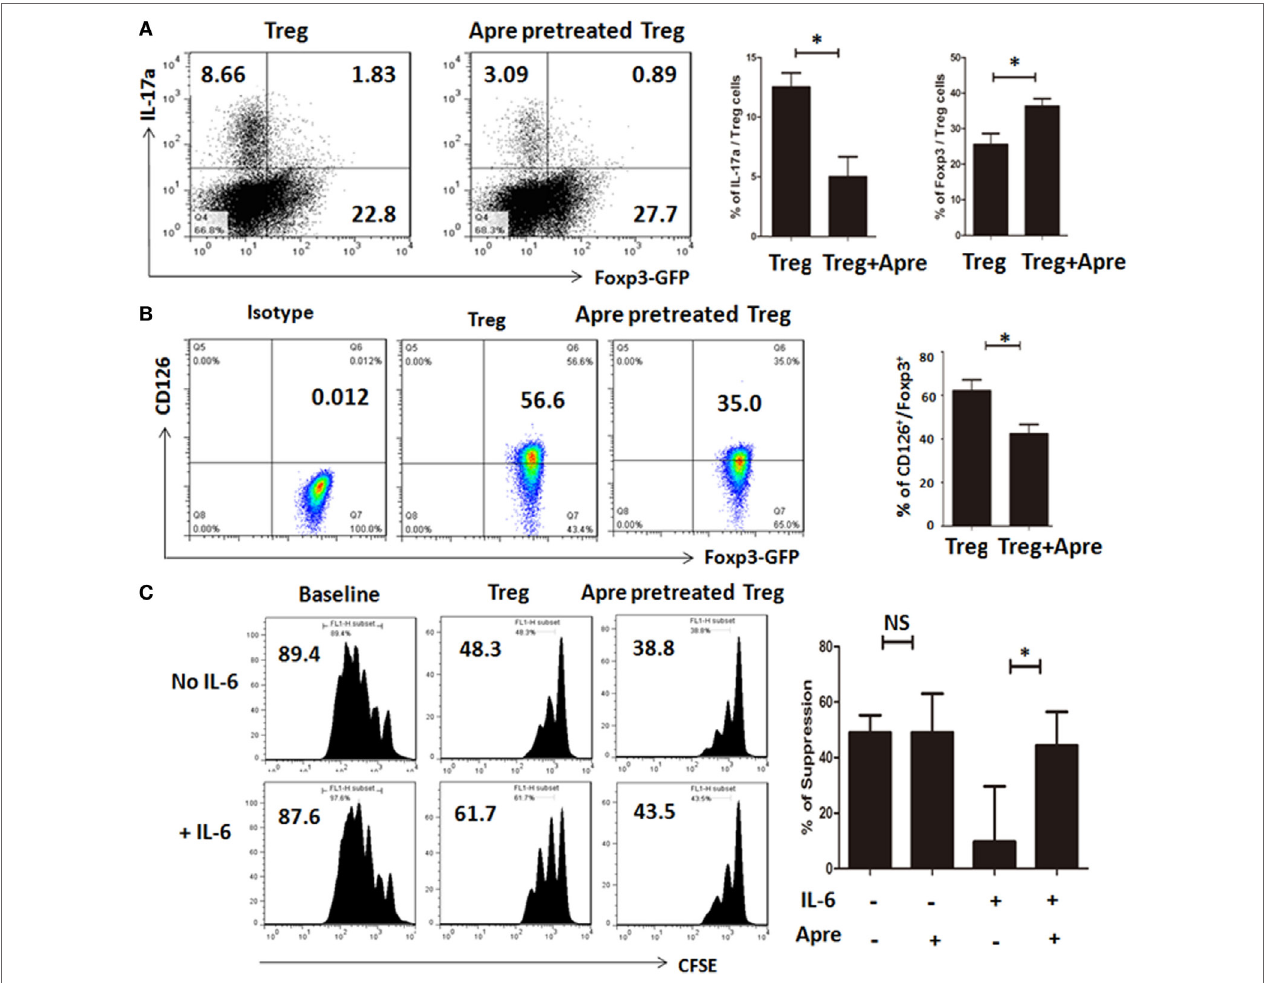
FigUre 5 | Apremilast promoted Treg by maintaining the Foxp3 stability and prevented Treg conversion to Th17 cells in vitro. (a) CD4 + CD25 + cells (Treg) were isolated with cell sorting and pretreated with 0.1 µM Apremilast or DMSO for 24 h, cultured under a condition polarizing Th17 cells for another 3 days. Then, the cells were harvested, tested for IL-17a and Foxp3-GFP expression by flow cytometry (mean ± SEM of three independent experiments, Mann–Whitney). (B) The CD126 expression was measured on Treg after pretreatment with 0.1 µM Apremilast or DMSO by flow cytometry and qPCR (mean ± SEM of three independent experiments, Mann–Whitney). (c) CFSE-labeled T cells were cultured with Treg (pretreated with DMSO) or Treg (pretreated with 0.1 µM Apremilast) in the presence of IL-6 or not at a 1:1 ratio, and suppression of cycling CFSE-labeled T cells was assessed flow cytometry (mean ± SEM of three independent experiments, Mann–Whitney) (* p <